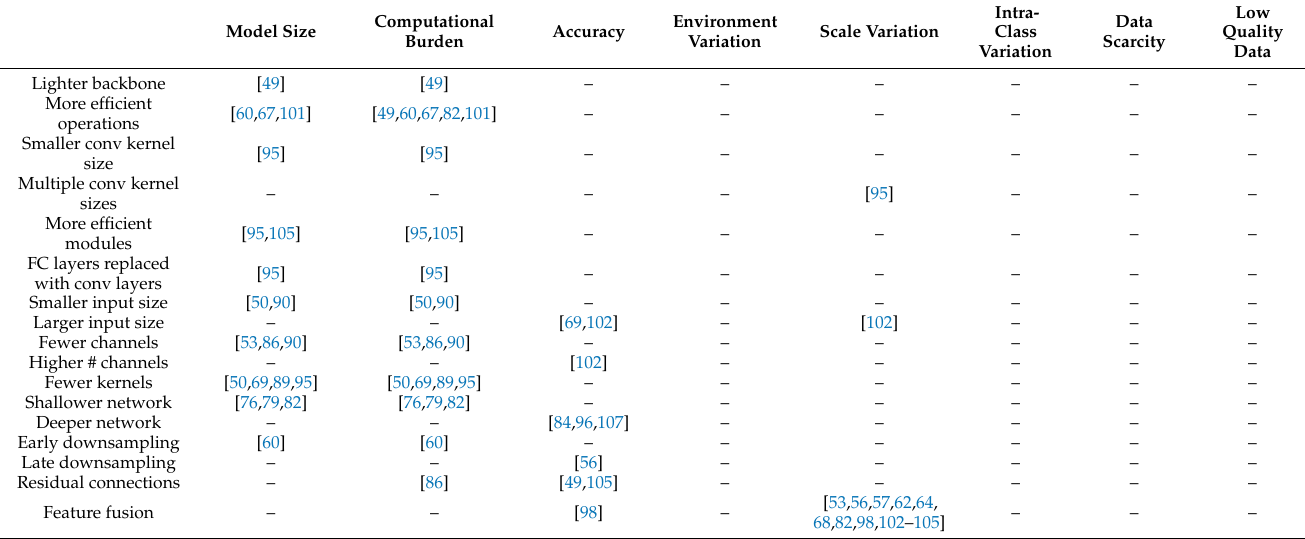
Table 3. Summary of the challenges faced in the reviewed studies and the explored strategies when developing on-device detection